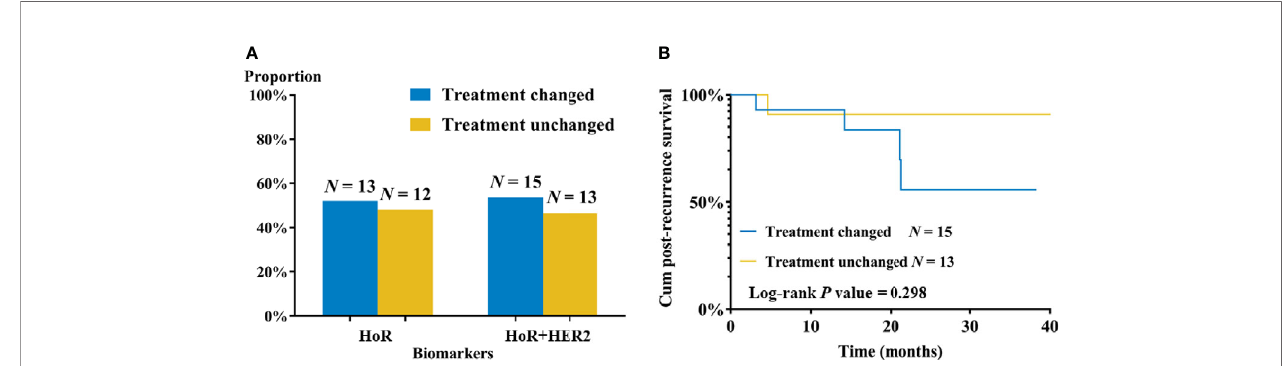
FIGURE 3 | Subsequent treatment and clinical outcome of recurrent ’ /metastatic breast cancer patients with molecular biomarker discrepancy. (A) Subsequent treatment changes according to molecular biomarker conversion. (B) Post-recurrence survival by subsequent treatment change. HoR, hormone receptor; HER2, human epidermal growth factor receptor-2.